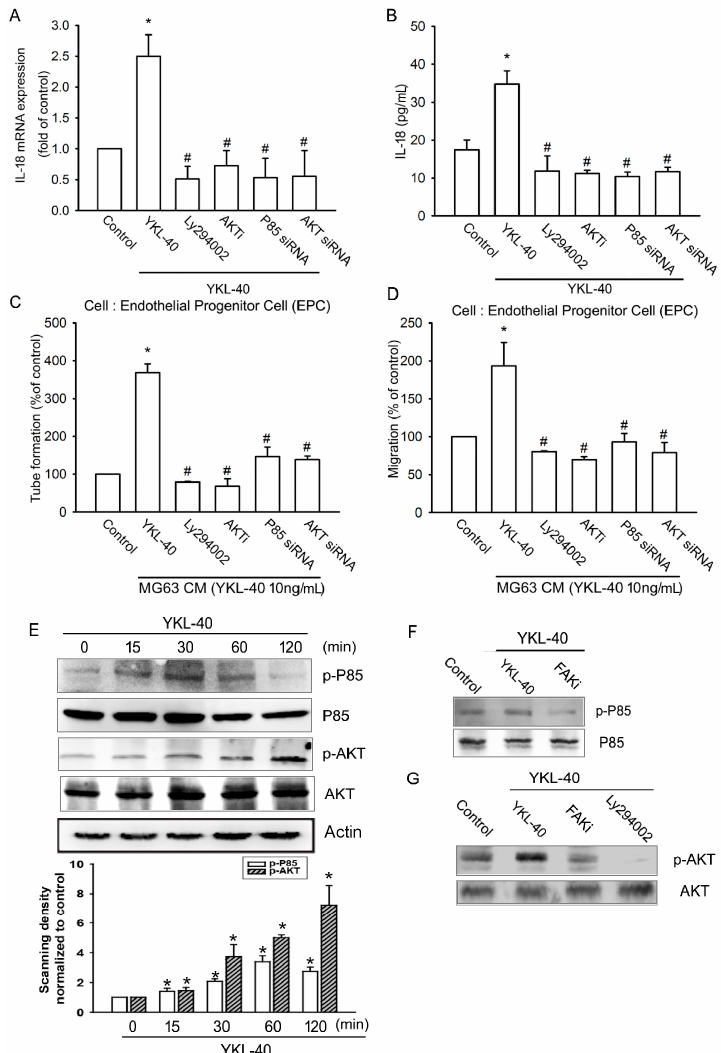
Figure 4. The PI3K/Akt signaling pathway regulates YKL-40-induced increases in IL-18 expression and angiogenesis. ( A , B ) MG-63 cells were pretreated with LY294002 (10 µ M) and an Akt inhibitor (10 µ M) or transfected with p85 and Akt siRNA for 24 h, then stimulated by YKL-40 for 24 h. IL-18 expression was examined by qPCR and ELISA ( n = 4 per group). ( C , D ) CM was collected and applied to EPCs. Capillary-like structure formation and cell migration of EPCs was examined by tube formation and Transwell assay ( n = 5 per group). ( E ) MG-63 cells were treated with YKL-40 for indicated time intervals, and p85 and Akt phosphorylation were examined by Western blotting. p85 and AKT phosphorylation in each independent experiment was quantified by densitometry ( n = 3 per group). ( F , G ) MG-63 cells were pretreated with a FAK inhibitor or LY294002 for 30 min then stimulated with YKL-40, and p85 and Akt phosphorylation activities were examined by Western blotting ( n = 3 per group). Results are expressed as the mean ± S.E. * p < 0.05 compared with control. # p < 0.05 compared with the YKL-40-treated group.